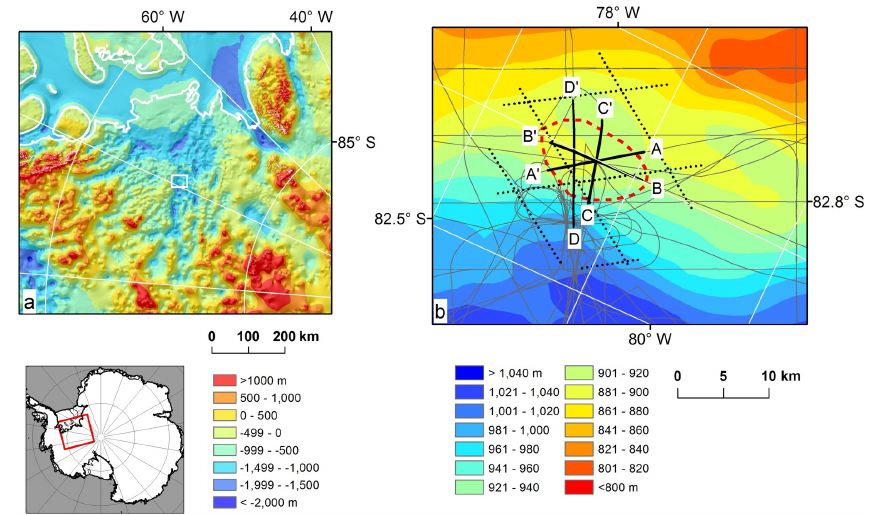
Fig. 1. (a) BEDMAP2 subglacial topography of the Institute Ice Stream region (with insert for study region in West Antarctica) (Fretwell et al., 2013). (b) Ice surface elevation with RES (grey lines) (Ross et al., 2012) and ICESat transects (black dotted lines) over and around Institute E2 (red dashed line), as delineated by Smith et al. (2009). RES lines in black, and labelled A–A’, B–B’, C–C’ and D–D’ refer to RES transects provided in Figs. 7 and 8. To assist comparison with Fig. 2, ICESat lines are oriented such that those closest to the 80 ◦ W longitude are also closest to the Easting’s axis in Fig.